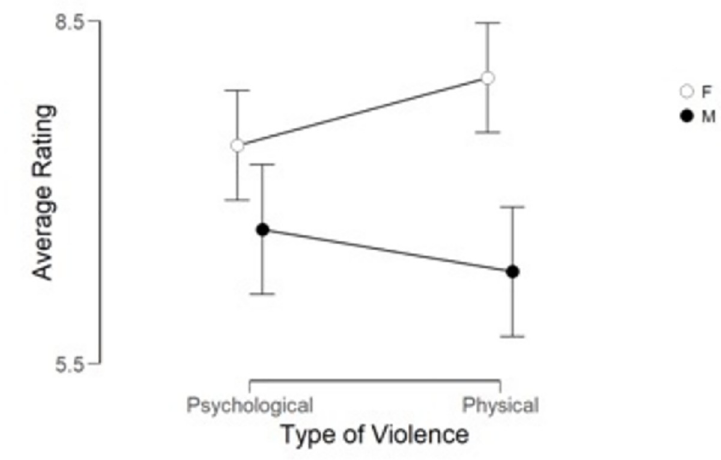
Fig 2. Narrator ratings of severity of violence divided by type of violence and gender in Phase 1. Note . F (hollow circle) stands for female and M (filled circle) for male gender, psychological violence is on the left side and physical on the right side. Bars show 95% confidence interval.